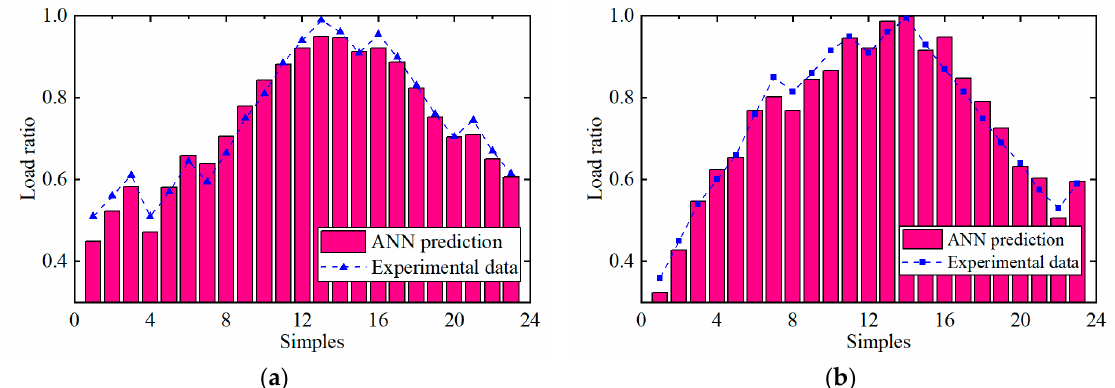
Figure 18. Comparison of conventional artificial neural network (ANN) predictions and experimental data; ( a ) the first stage; ( b ) the second stage.